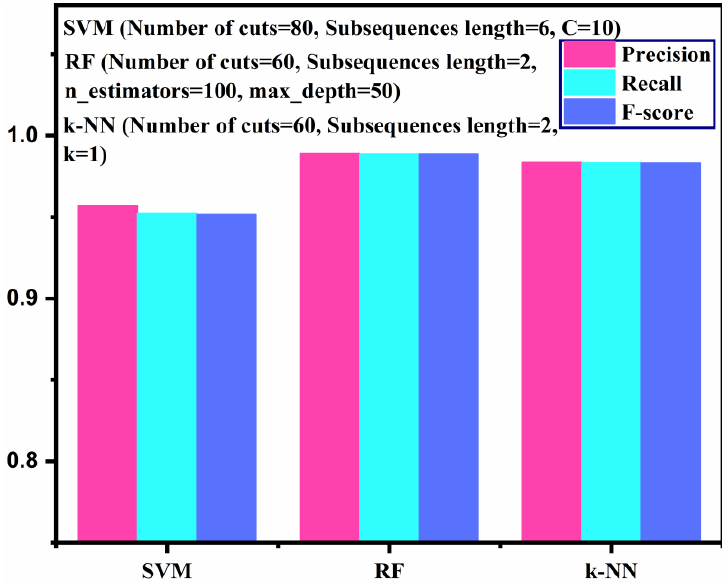
Figure 9. Precision, recall, and F-score results for K-mer-based machine learning algorithms.